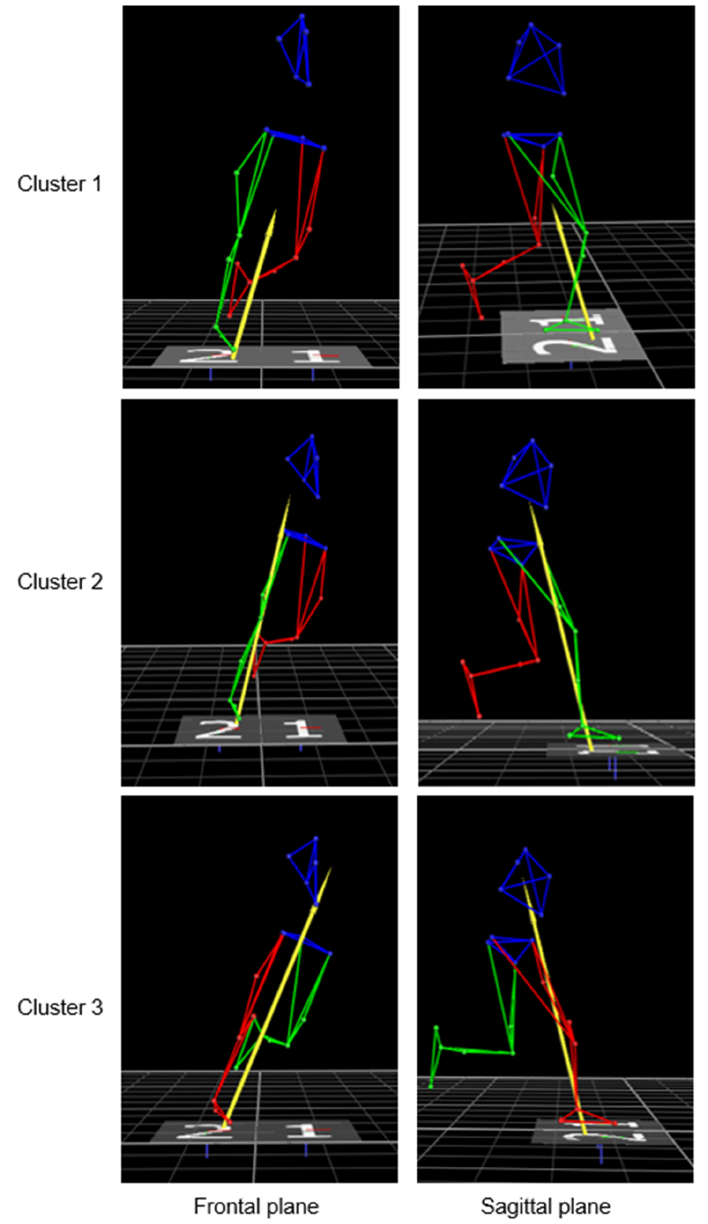
Figure 4. Example of trials belonging to Cluster 1 (first row), Cluster 2 (second row), and Cluster 3 (third row) from frontal ( left ) and sagittal ( right ) view. The frame represents initial contact. Cluster 1 had lowest peak knee moments in the three planes and was considered low ‐ risk; Cluster 2 had high knee extension moment at initial contact and was considered mid ‐ risk (note the higher magnitude and the vector close to the knee on sagittal plane); Cluster 3 had high knee abduction